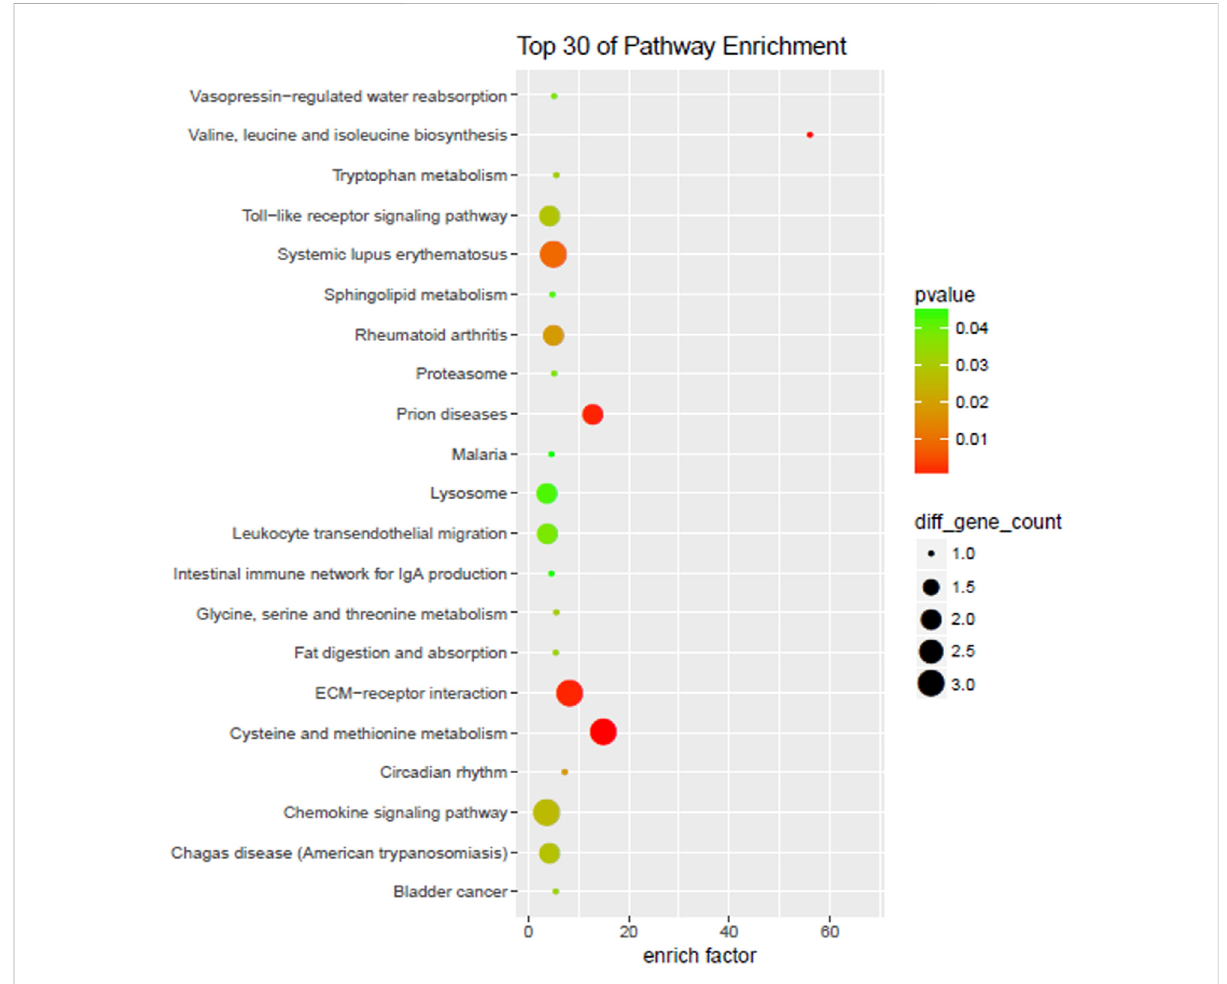
FIGURE 5 KEGG enrichment.